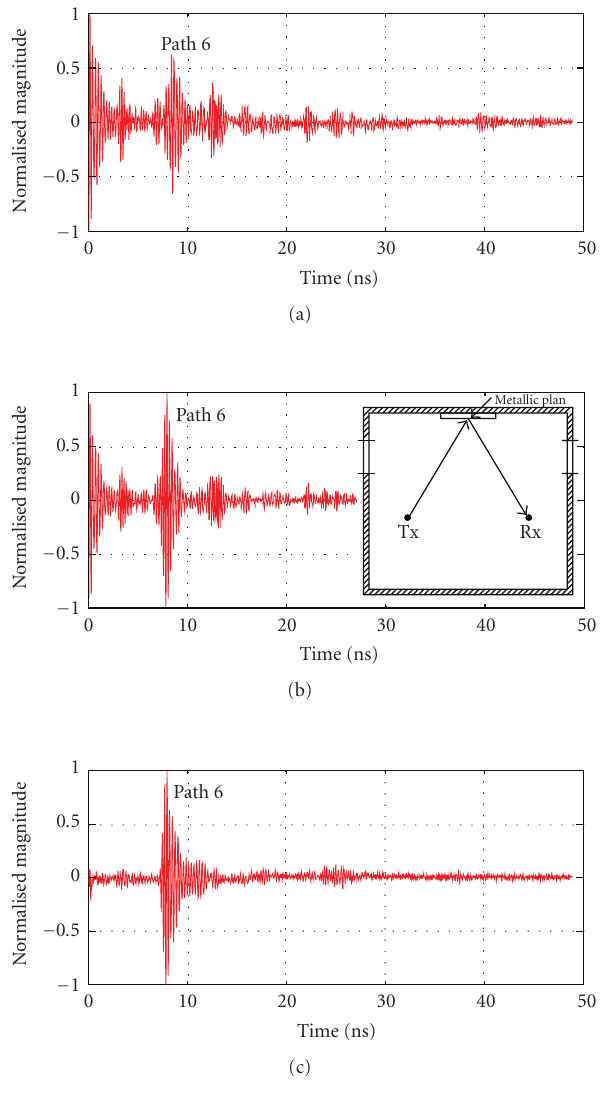
Figure 18: Pointed echo by MTI technique: subtraction between the pulse response of the room (a) and a pulse response (b) with metallic plan put in the way labelled 6 (cf. Figure 16) to increase the reflection phenomenon.